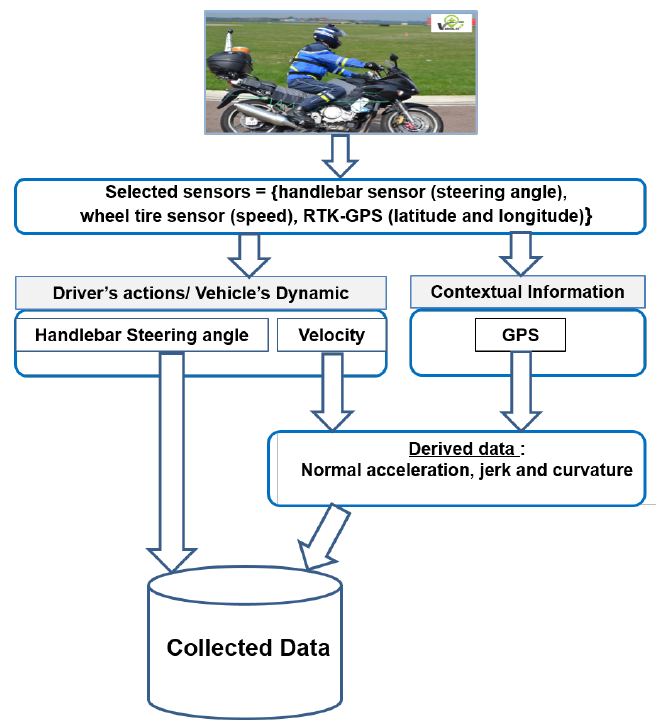
Figure 3. Data collection